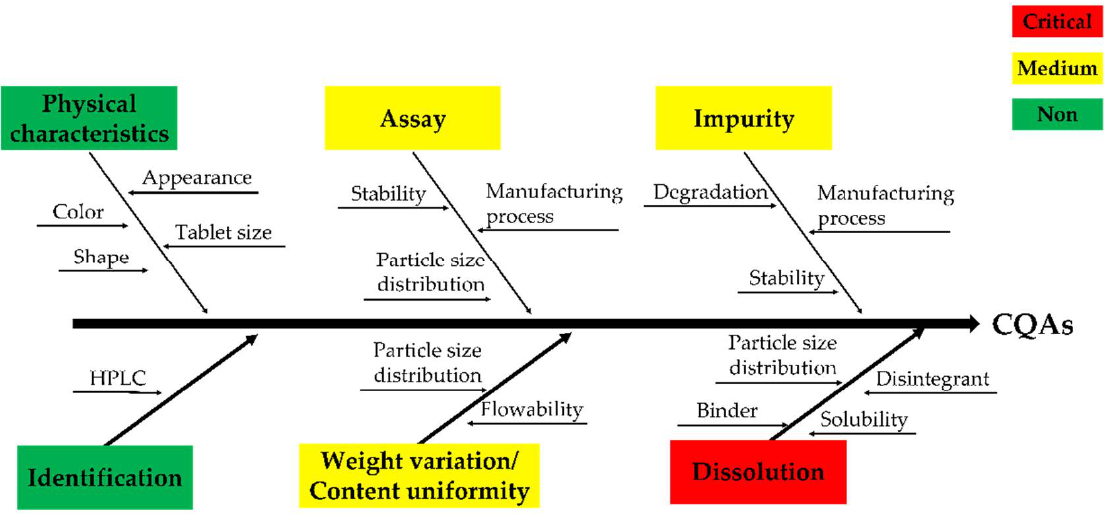
Figure 1. Fishbone/Ishikawa diagram regarding the critical quality attributes (CQAs).